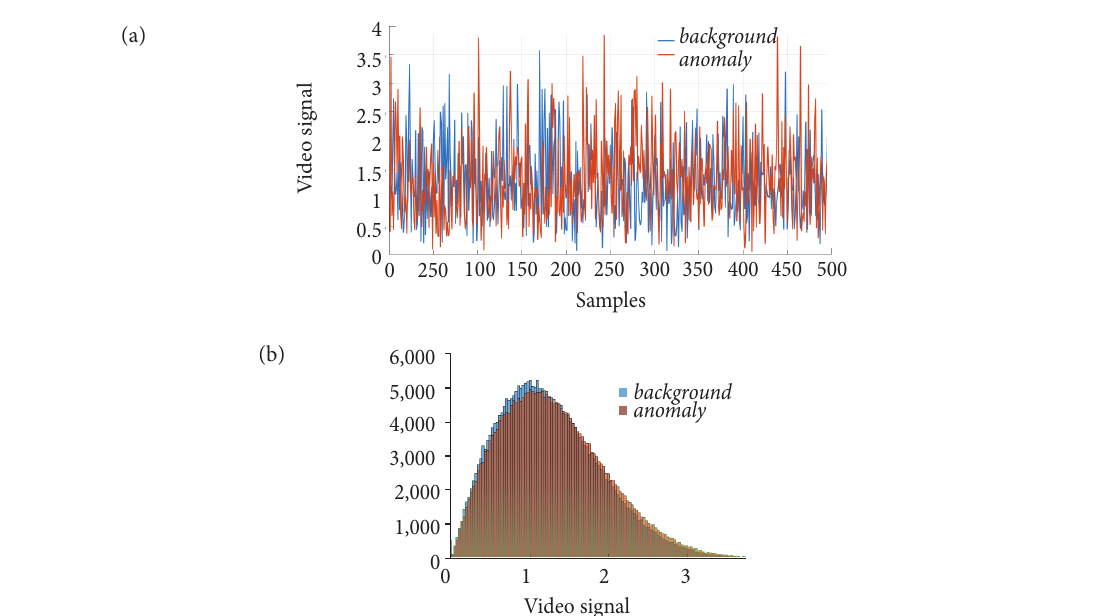
Figure 5. One realization of the cellular emission (a) and histogram (b) of the samples under both hypotheses: the background has a Rayleigh density with σ = 1 and the anomaly is Rician with A = 0,4 and σ =